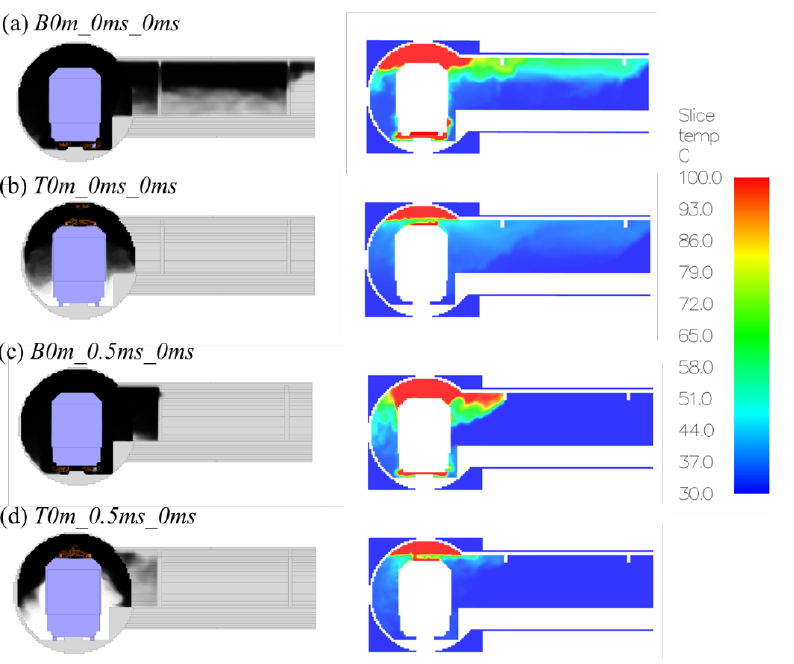
Figure 9. Comparison of temperature and smoke distribution of cross-passage between top and undercarriage fires: ( a ) B0m_0ms_0ms ( b ) T0m_0ms_0ms ( c ) B0m_0.5ms_0ms and ( d ) T0m_0.5ms_0ms .